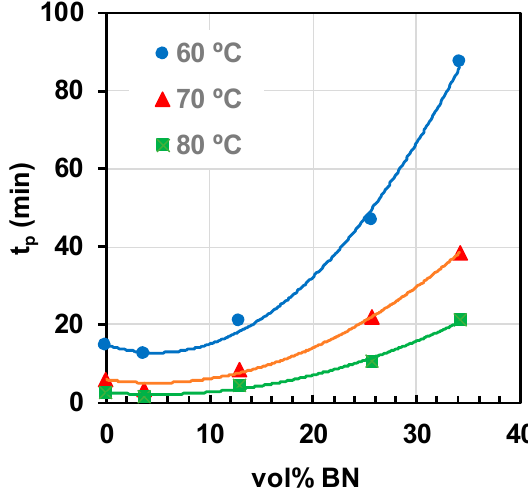
Figure 6. Dependence of time to peak exotherm, t p , on content of 2 µ m BN platelets for epoxy-BN composites in isothermal cure at 60 °C (blue circles), 70 °C (red triangles) and 80 °C (green squares).